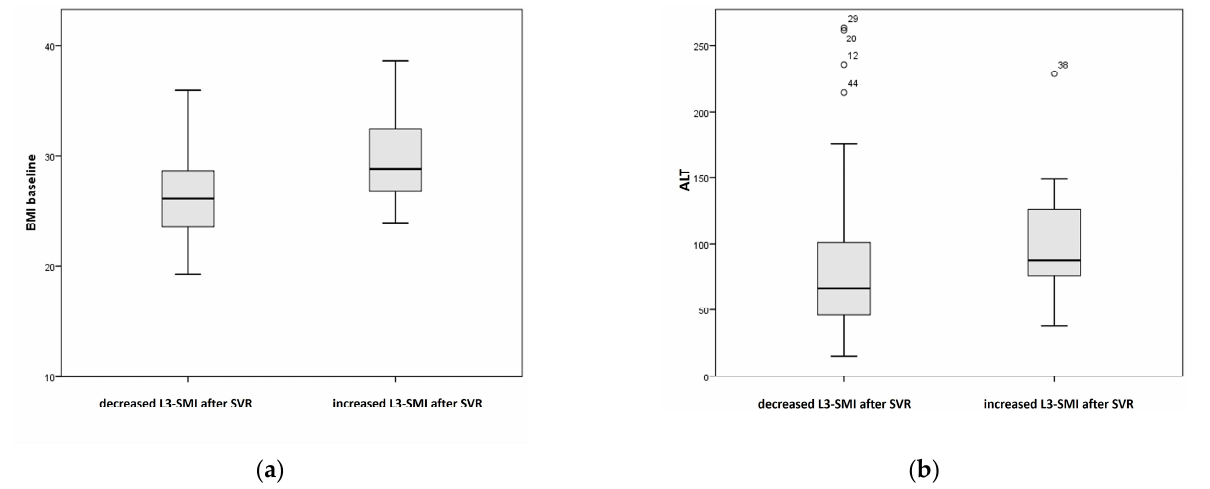
Figure 2. Boxplot for BMI ( a ) and ALT ( b ) values for patients with decreased L3-SMI and patients with increased L3-SMI after SVR.